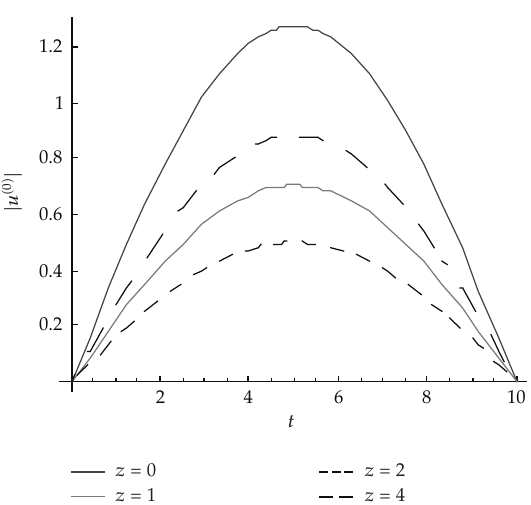
Figure 32: The zero-order approximation | u (cid:3) 0 (cid:4) | at α (cid:8) 1, T (cid:8) 10, γ (cid:8) 0 for di ff erent values of z , considering only one term in the series (cid:3) M (cid:8) 1 (cid:4)